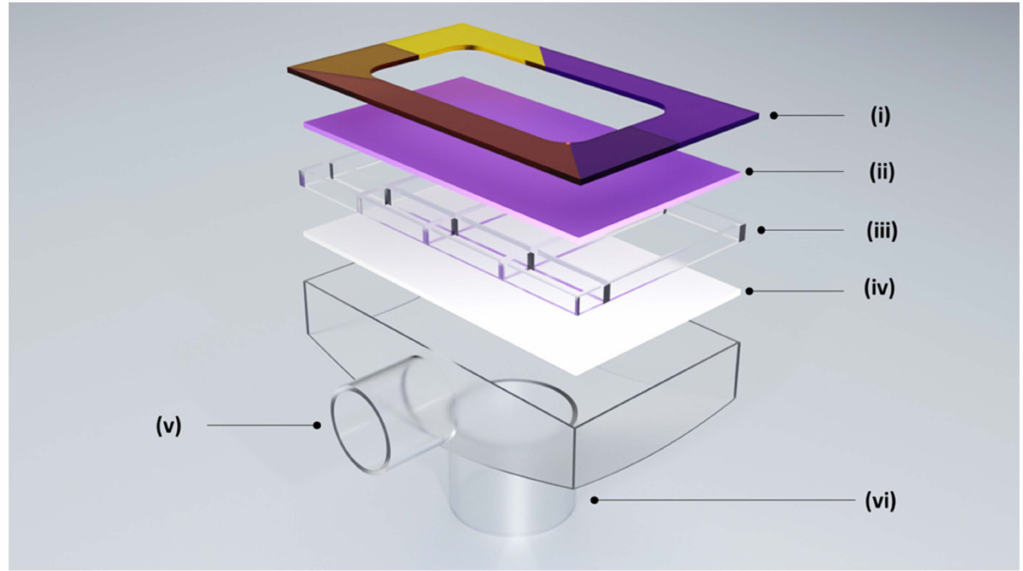
Figure 4. Schematic illustration of the key components of a Nellcor™ Easy Cap II Adult Colourimetric CO 2 Detector, the ‘Easy Cap detector’, where (i) is the outer plastic casing with colour wheel, (ii) Easy Cap indicator film, (iii) internal plastic support, (iv) white water-vapour absorbing layer and (v) and (vi) are the endotracheal tube and air/anaesthetic inlet gas connections,